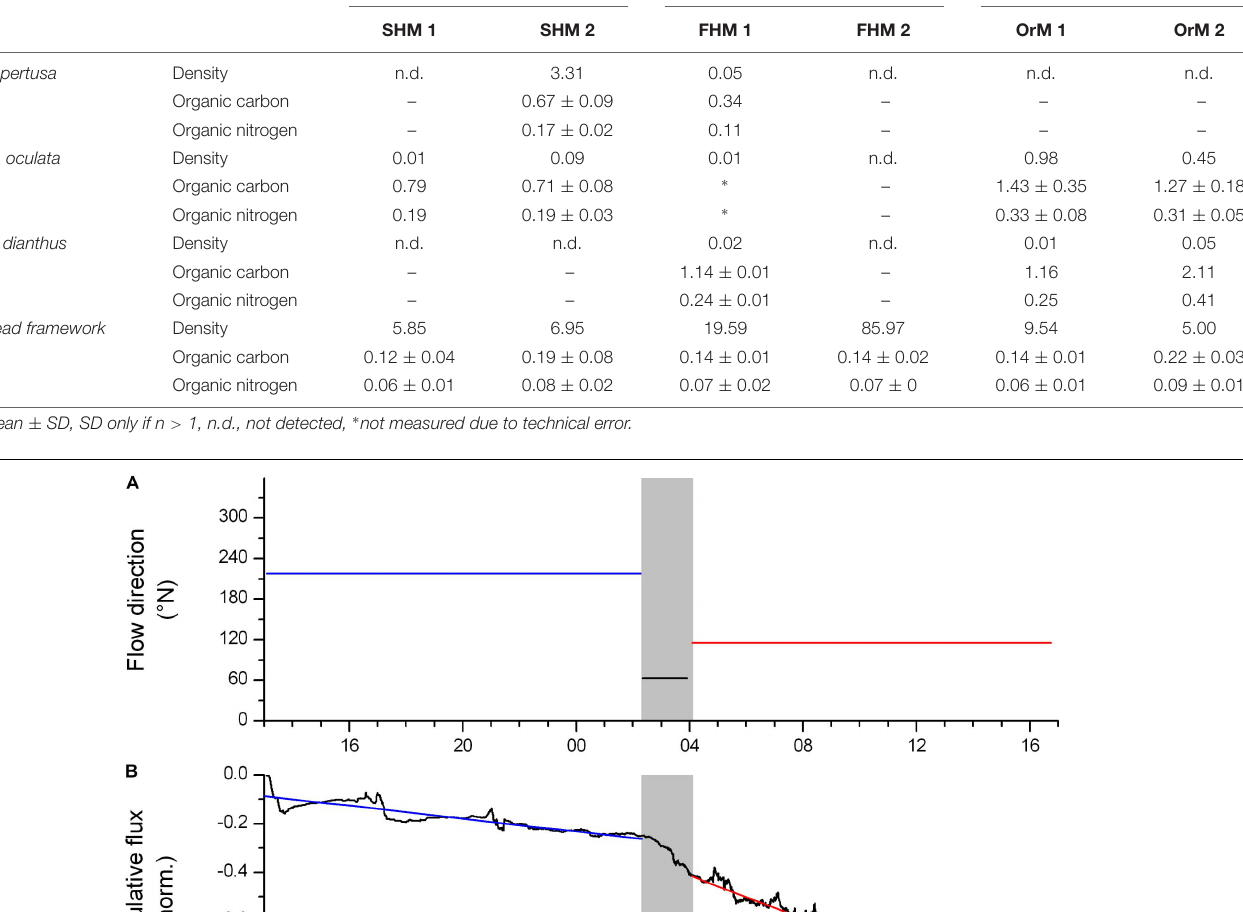
TABLE 3 | The density (kg dry weight m − 2 ), organic carbon content (%) and organic nitrogen content (%) of the living corals and dead coral framework for box core. Summit Haas mound